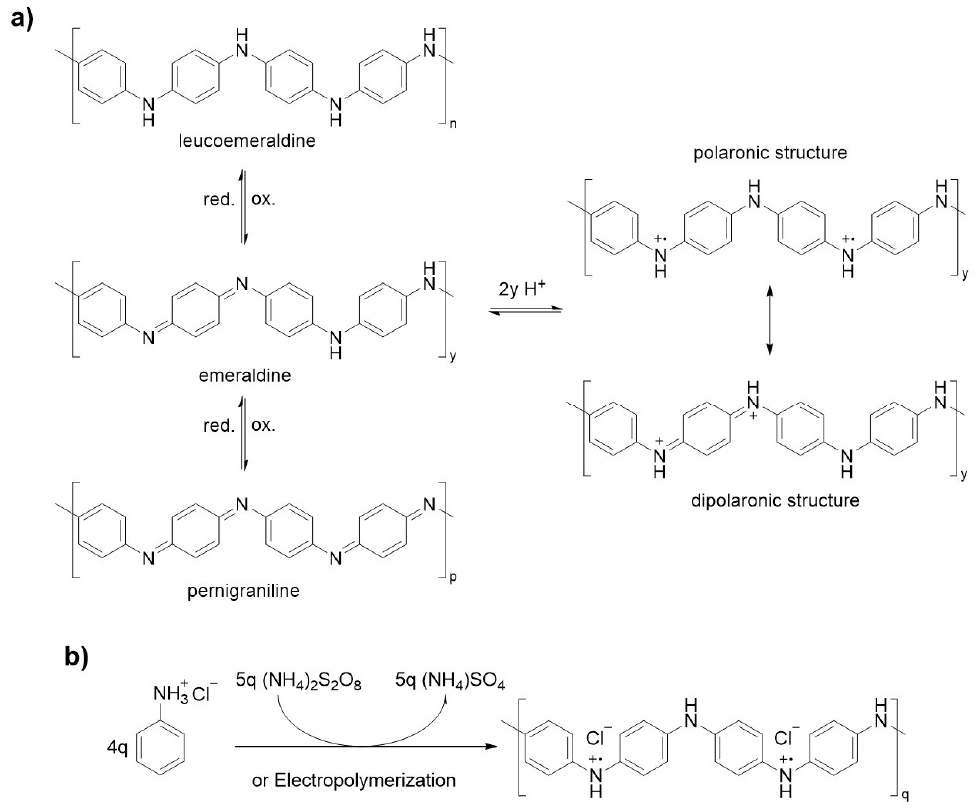
Figure 1. Skeletal formulas of polyaniline in different oxidation states and their resonance, ( a ) leucoemeraldine, ( b ) Oxidative chemical polymerization.